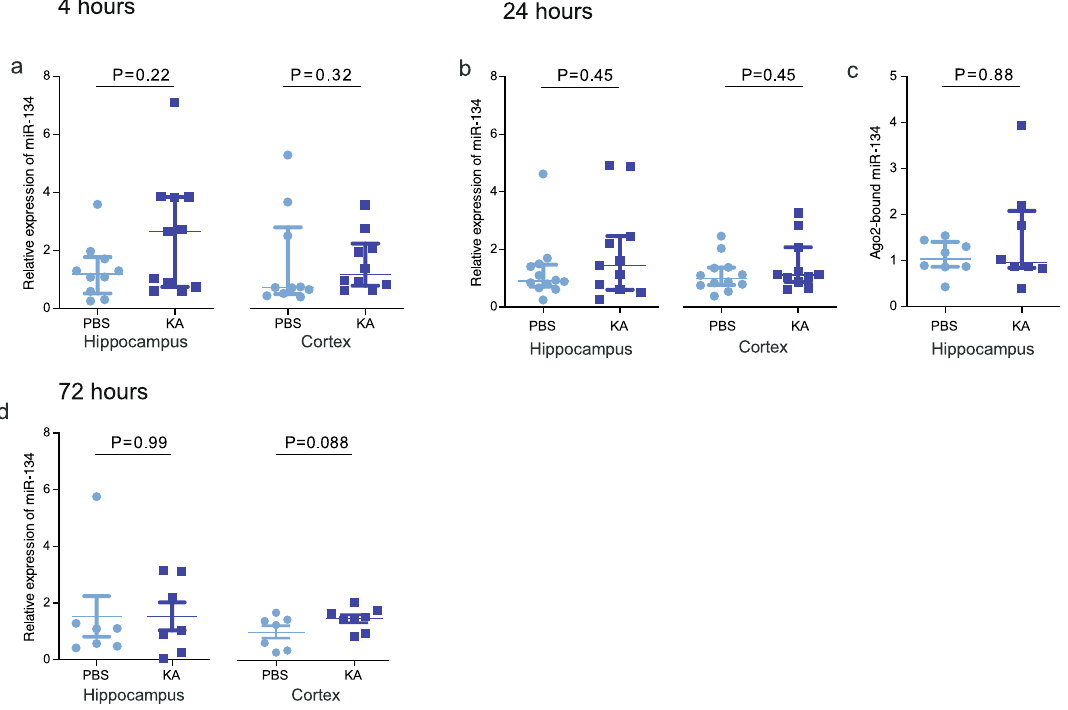
Figure 3. Systemic KA does not alter miR-134 expression in P21 mice. Graphs show real-time quantitative PCR analysis of miR-134 expression in hippocampal and cortical lysates at different time points after systemic KA injection, with counts normalised to RNU6B. ( a ) Overall miR-134 expression at 4 h (N = 10–11/group). ( b ) Overall miR-134 expression at 24 h (N = 11–12/group). ( c ) Ago2-bound (functionally engaged) miR-134 in hippocampus at 24 h (N = 8/group). ( d ) miR-134 expression at 72 h (N = 7/group).